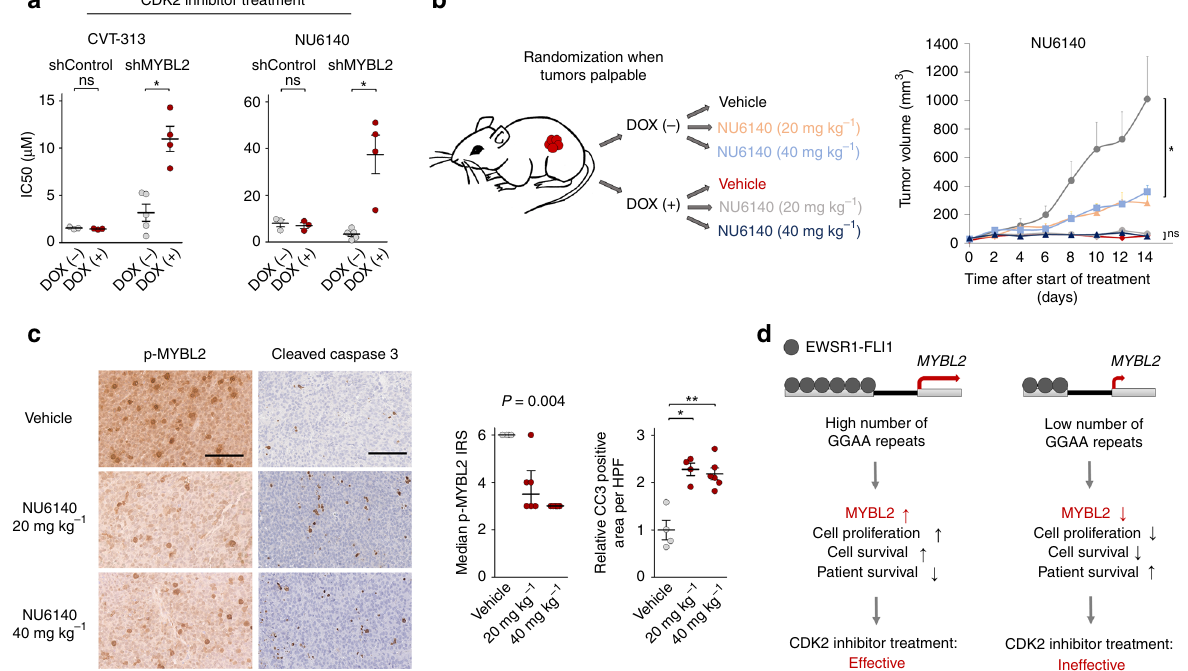
Fig. 4 High MYBL2 expression levels sensitize EwS cells toward treatment with CDK2 inhibitors in vitro and in vivo. a Analysis of IC50 of CDK2 inhibitors CVT-313 and NU6140 in A673 cells containing either DOX-inducible speci fi c shMYBL2 or non-targeting shControl constructs. Horizontal bars represent means, and whiskers represent the SEM, n ≥ 3 biologically independent experiments; P values determined via two-tailed Mann – Whitney test. b Left: Schematic of the experimental setting of CDK2 inhibitor treatment (NU6140) in vivo. NSG mice were xenografted with A673 cells containing a DOX- inducible shMYBL2 construct, treated with/without DOX and either vehicle or NU6140 in a dose of 20 mg kg − 1 or 40 mg kg − 1 . Mice were randomized to the treatment groups when tumors were palpable. Right: For each condition the mean tumor volume and SEM of 4 – 6 mice over the time of treatment are shown; P values determined via two-tailed Mann – Whitney test. c Left: Representative IHC micrographs of p-MYBL2 and cleaved caspase 3 (CC3) staining of A673/TR/shMYBL2 xenografts (DOX ( – )) treated with either vehicle or NU6140. Scale bar is 100 µ m. Right: Quanti fi cation of positivity for p-MYBL2 and CC3, respectively. Horizontal bars represent medians or means, and whiskers interquartile ranges or SEM for p-MYBL2 or CC3, respectively, n ≥ 4 samples per condition; P values determined via Kruskal – Wallis test (p-MYBL2) or two-tailed Mann – Whitney test (CC3). d Model of EWSR1-FLI1- dependent regulation of MYBL2 via the MYBL2 -associated GGAA-microsatellite in EwS. Not signi fi cant, ns; *** P < 0.001, ** P < 0.01, * P < 0.05. Source